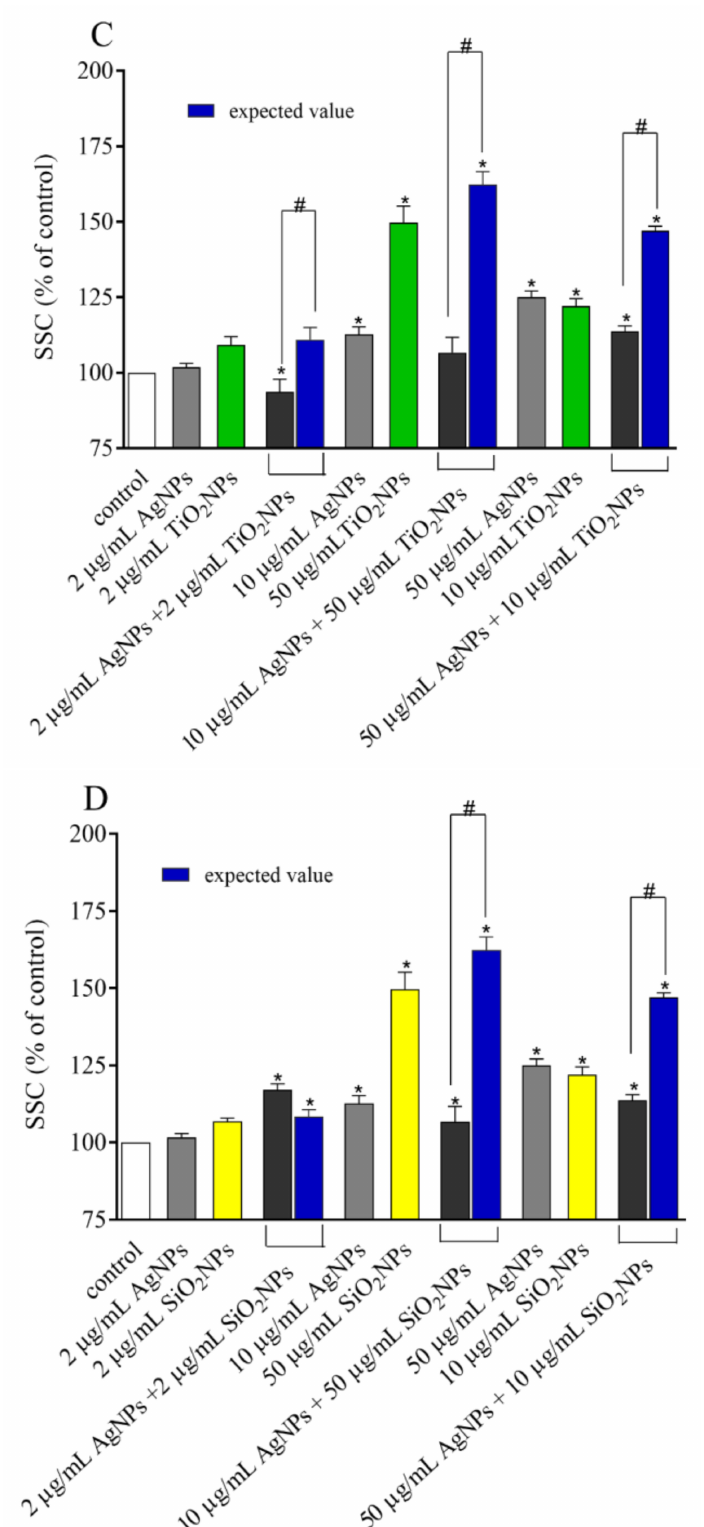
Figure 1. Uptake / binding of the single NPs or combination of AgNPs with ( A ) AuNPs, ( B ) CdTe quantum dots (QDs), ( C ) TiO 2 NPs, and ( D ) SiO 2 NPs. Means ± SD, n = 3. * denotes a statistically significant di ff erence from the unexposed control, Student’s t-test applied to raw data, P < 0.05. # denotes a statistically significant di ff erence between the observed and expected value, Student’s t-test applied to raw data, P <